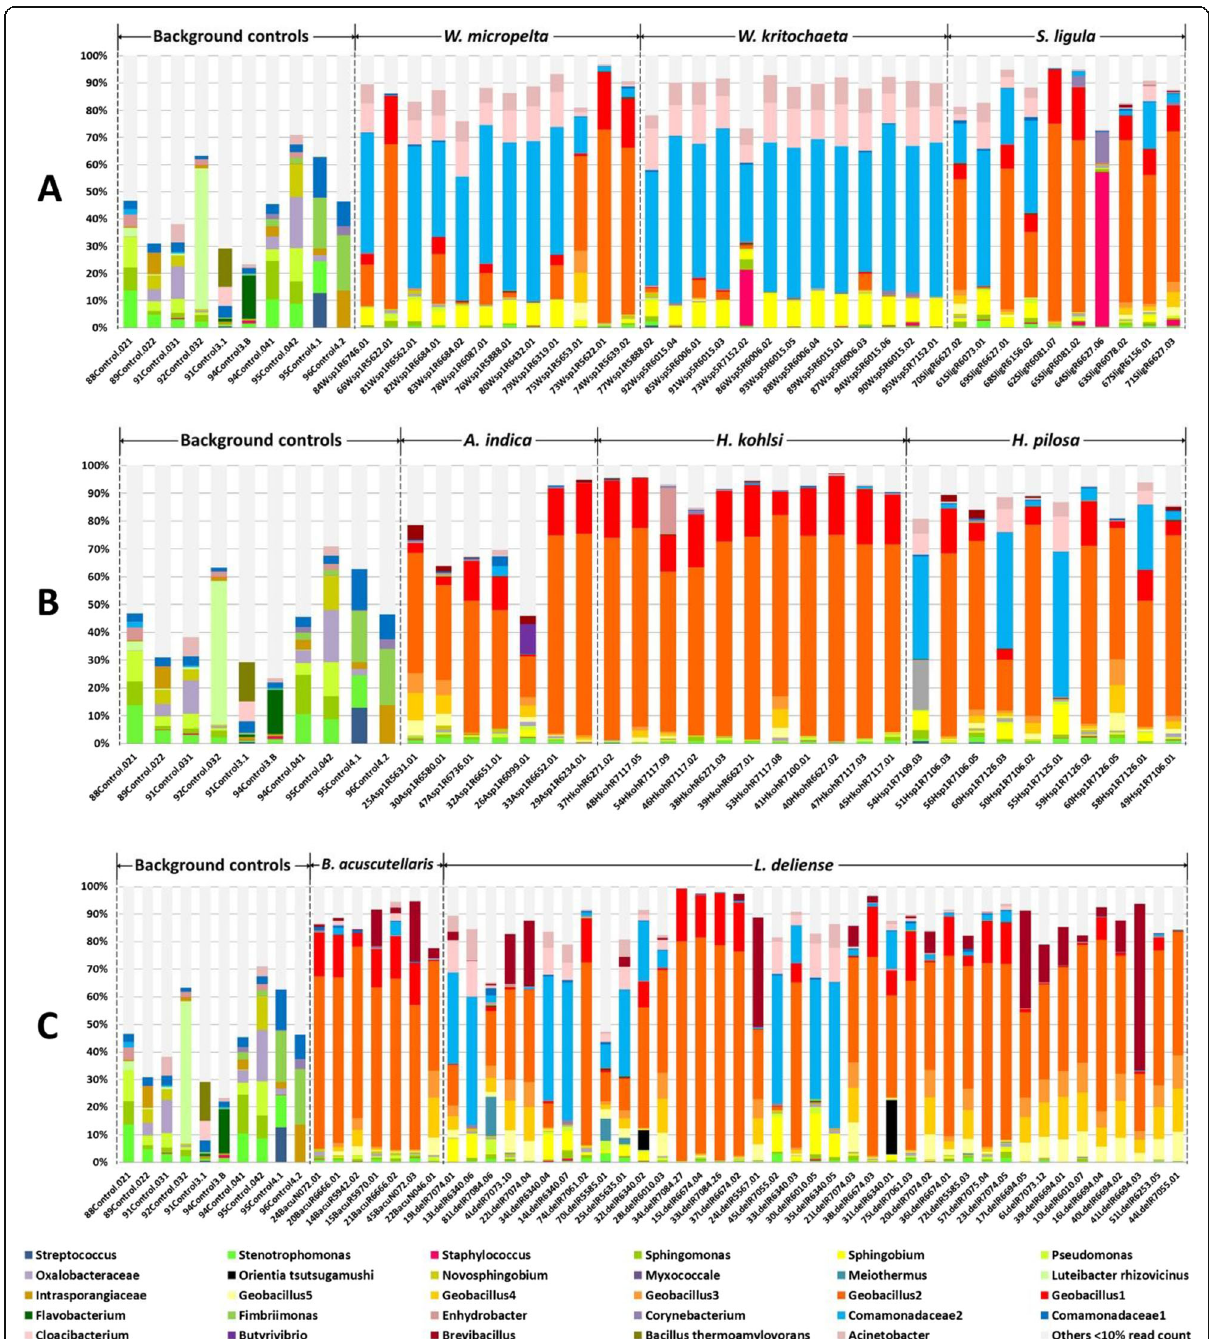
Fig. 5 Relative abundance of bacterial OTUs in background controls and individual chiggers. a subfamily Gahrliepiinae and subfamily Trombiculinae. b Tribe Schoengastiini. c Tribe Trombiculini. The data are filtered; OTUs that represented < 10% in a sample were combined in “ others ” (light grey) to aid visualisation. Source data are included in Additional file